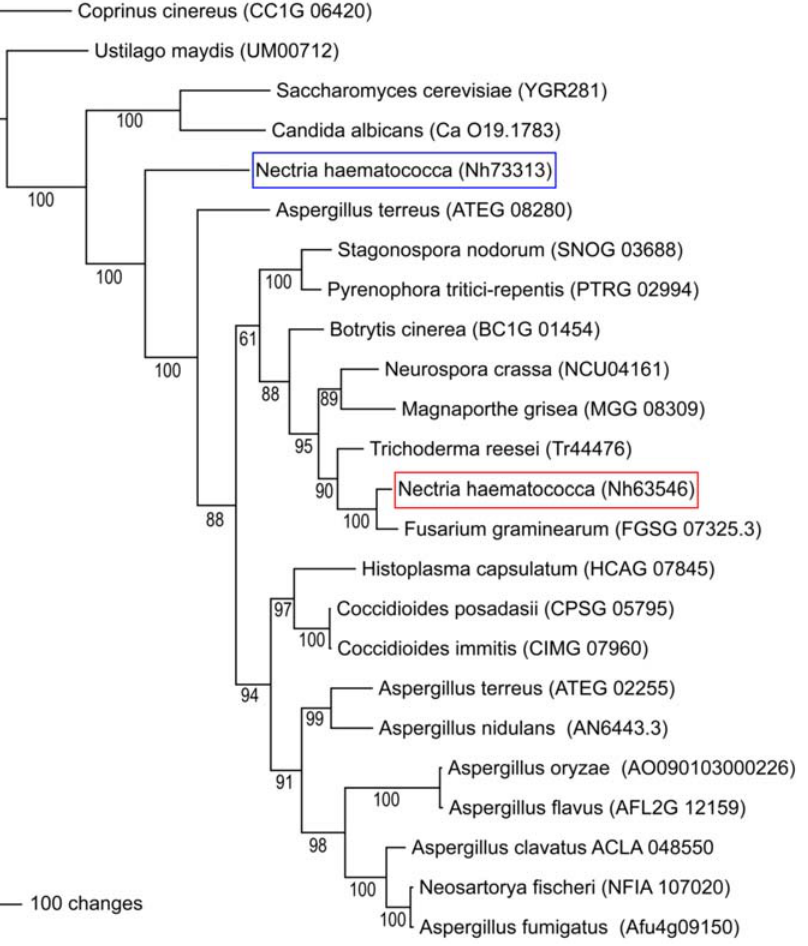
Figure 3. The phylogenetic relationship of the ABC transporter YOR1 from selected fungal genomes. Maximum parsimony analysis was used to establish the phylogenetic relationship between the ortholog (Nh63546, red box) and the pseudoparalog (Nh73313, blue box) of N. haematococca MPVI.